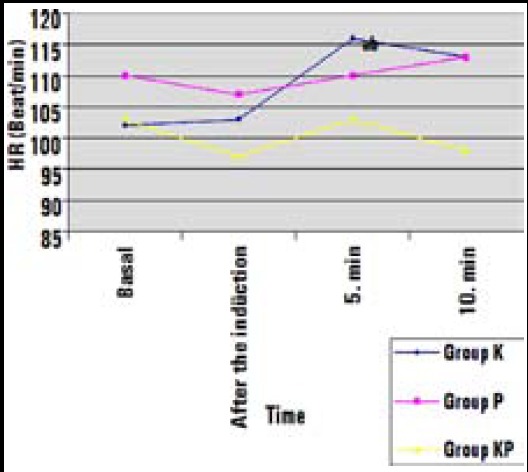
Heart Rate of the groups (beat/min) aHigher in Group K than Group KP, bSignificant increase compared with baseline.